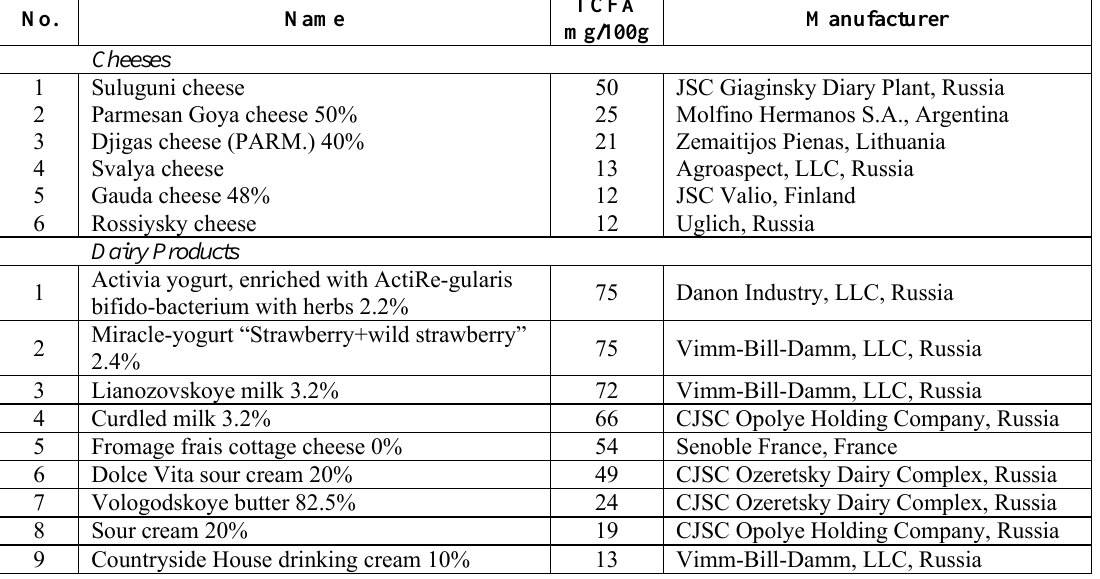
Table 3. Total Content of Fat-Soluble Antioxidants (TCFA) in Cheese & Other Dairy Products (standard - gallic